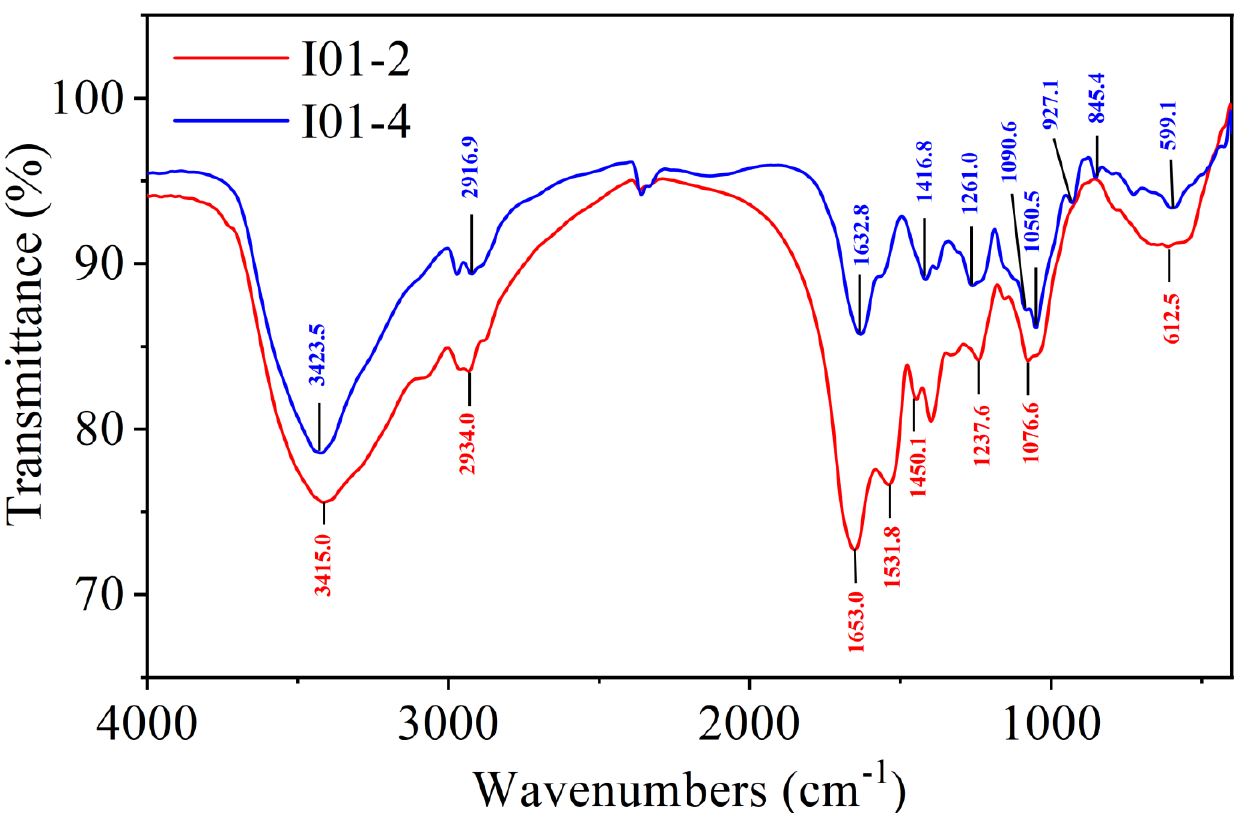
Figure 3. FT-IR spectra of I01-2 and I01-4 in the range of 400 – 4000 cm −1 .